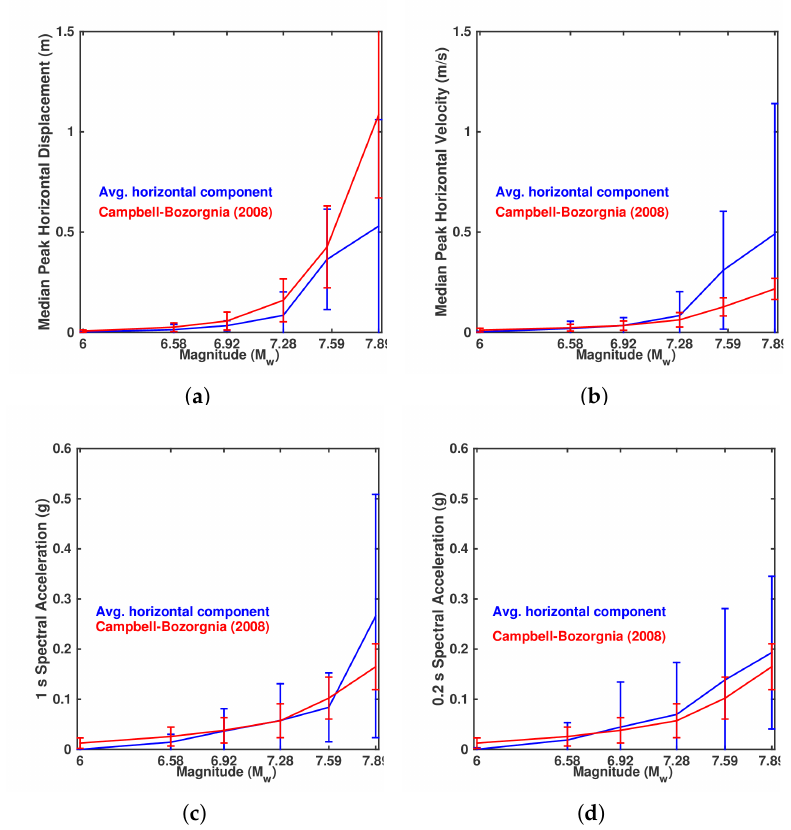
Figure 5. ( a , b ) Median peak geometric mean horizontal displacement (m) and velocity (m/s). ( c , d ) 5%-damped spectral acceleration at 1 s and 0.2 s periods, in units of “g”, plotted as a function of earthquake magnitude from scenario earthquake simulations (blue lines) and the Campbell-Bozorgnia NGA (red lines). The vertical bars correspond to the one standard deviation spread above and below the median